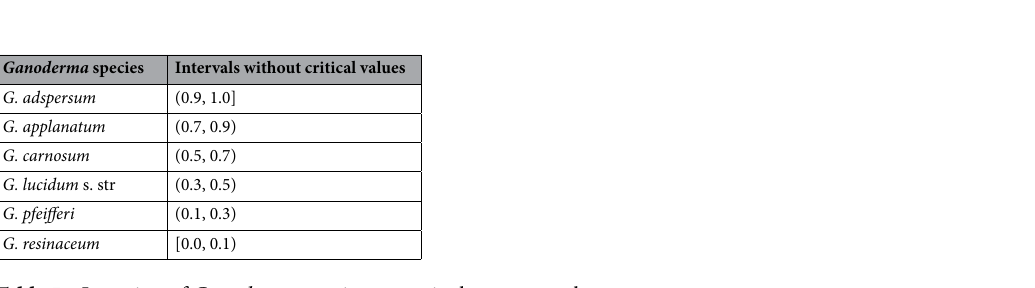
Table 5. Insertion of Ganoderma species to particular output